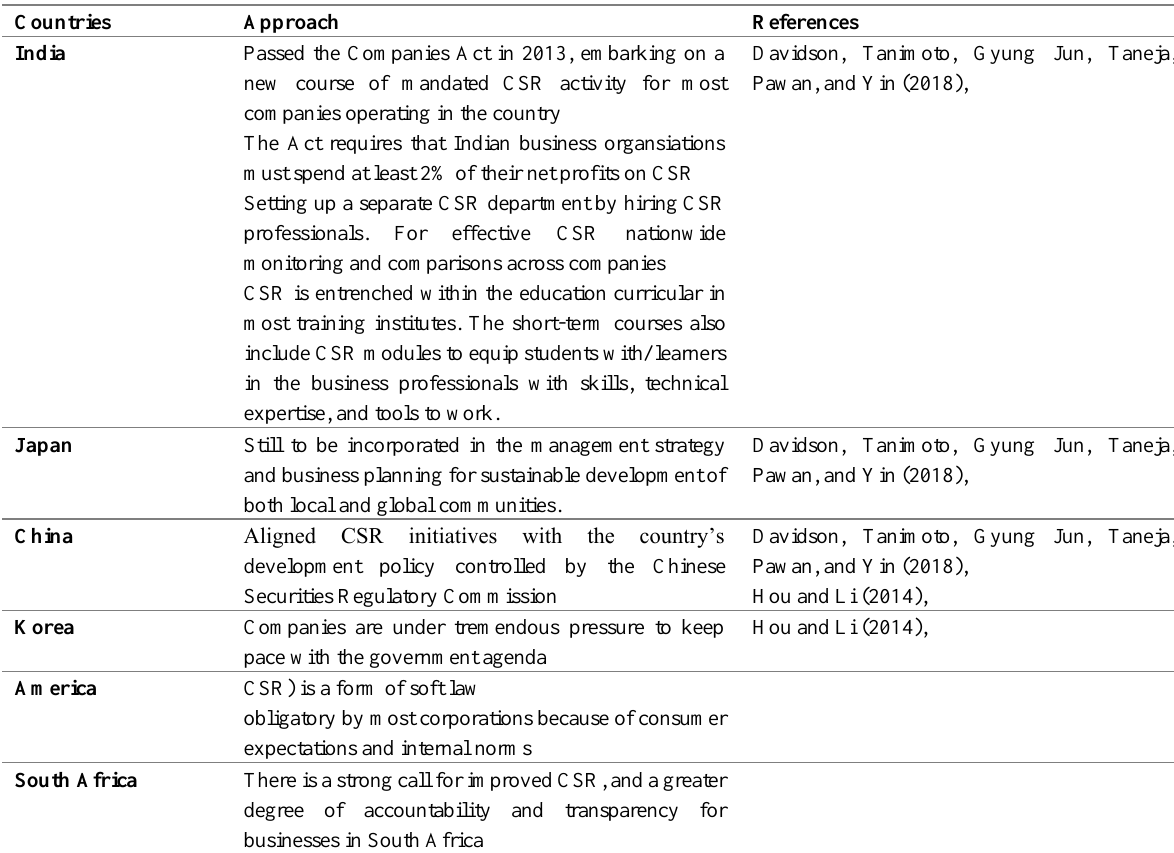
Table 2: Country Specific Csr